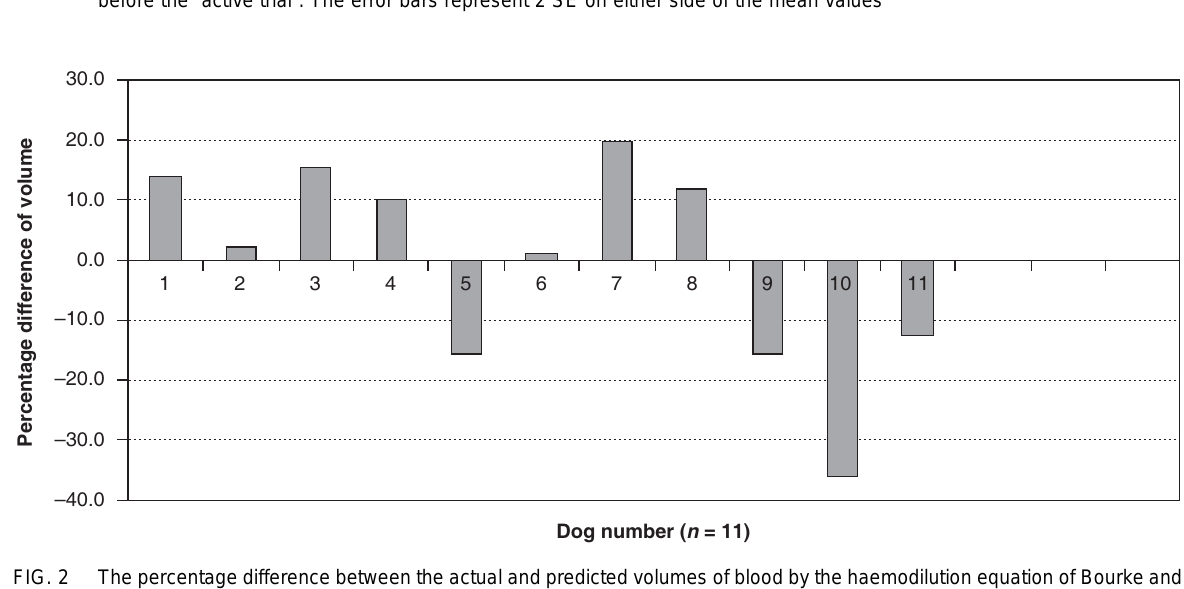
FIG. 2 The percentage difference between the actual and predicted volumes of blood by the haemodilution equation of Bourke and Smith (1974) to achieve the final Ht for each dog. A percentage difference of 0 would indicate that the actual and predict- ed blood volumes were the same. A positive percentage means that the actual blood volume was in excess of the predict- ed blood volume, while a negative percentage means that the actual volume was less than the volume